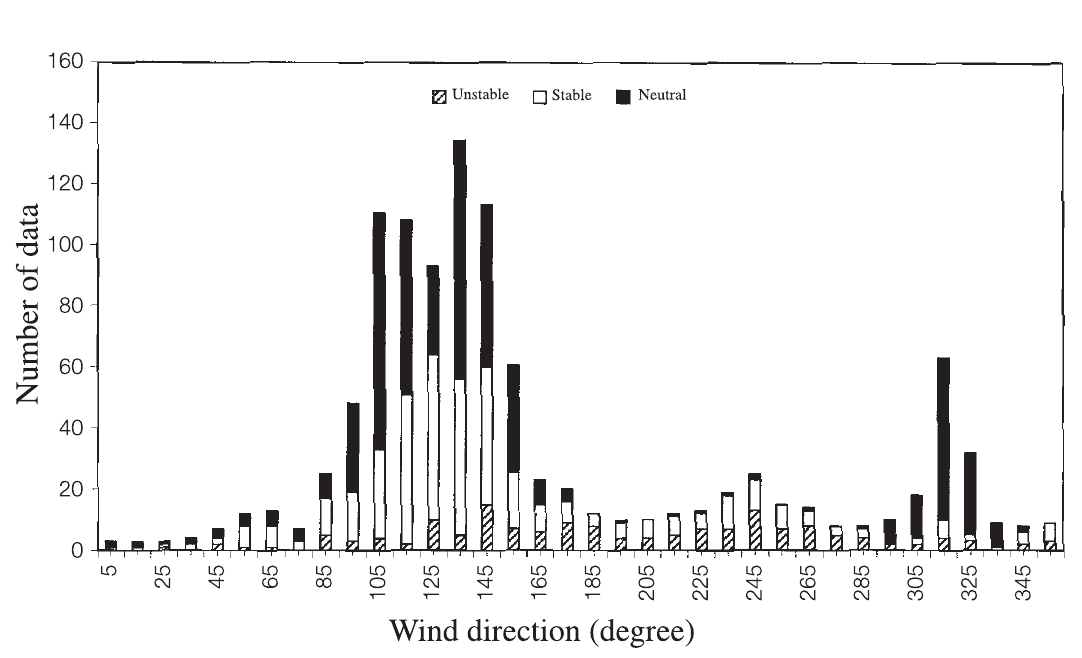
Fig. 5. Histogram with the distribution of the observed cases for three different stability classes, unstable: z/L < – 0.05; neutral: – 0.05 < z/L < 0.05; stable: z/L > 0.05 during